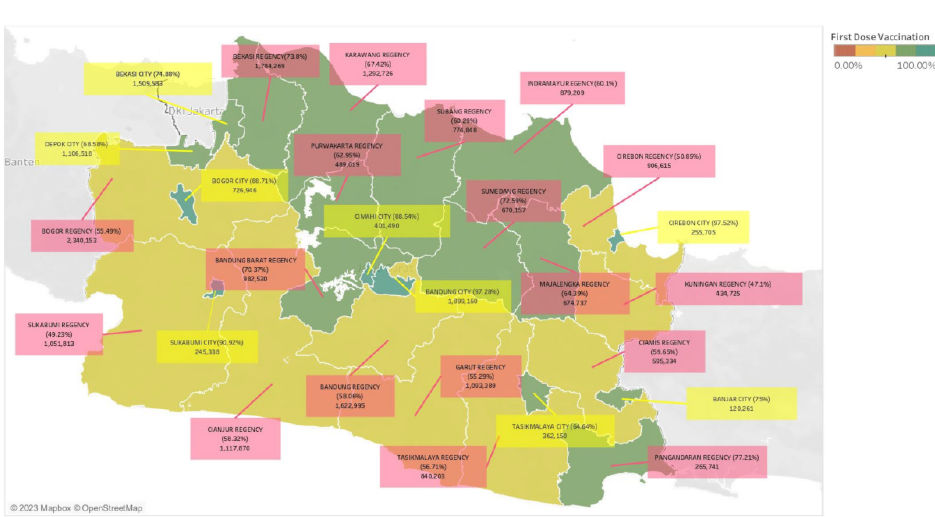
Figure 1. Total of first dose vaccination number and vaccination coverage in West Java as of 23 November 2021. The map color represents vaccination coverage and the box color represents regional status; pink for regency areas and yellow for city areas.